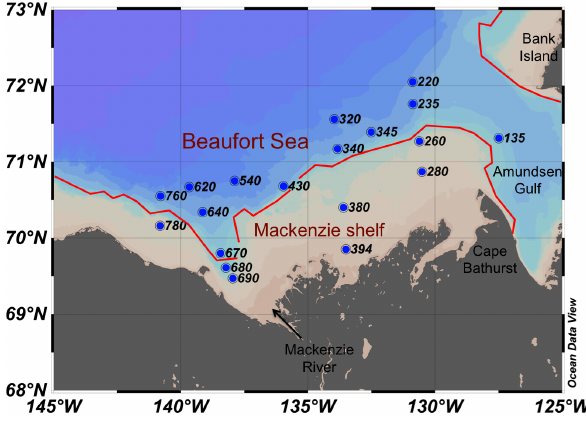
Figure 1. Location of the sampling stations in the Canadian Beau- fort Sea from 30 July to 27 August 2009 during the MALINA ex- pedition. The isobath 150m (in red) separates the Mackenzie shelf from the deep waters of the Beaufort